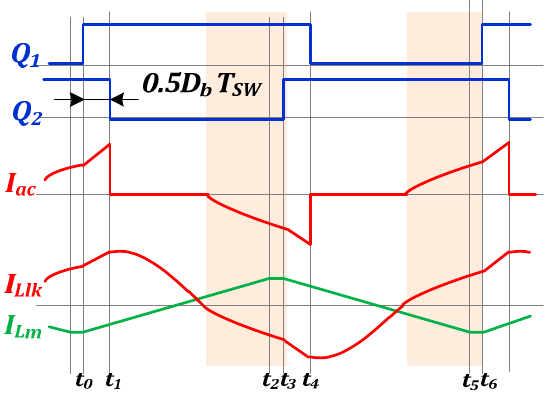
Figure 3. Abnormal operation of the proposed SRC with a boost VDR in the case of PWM scheme from Figure 2b when Δ V Cr /2 > nV IN .